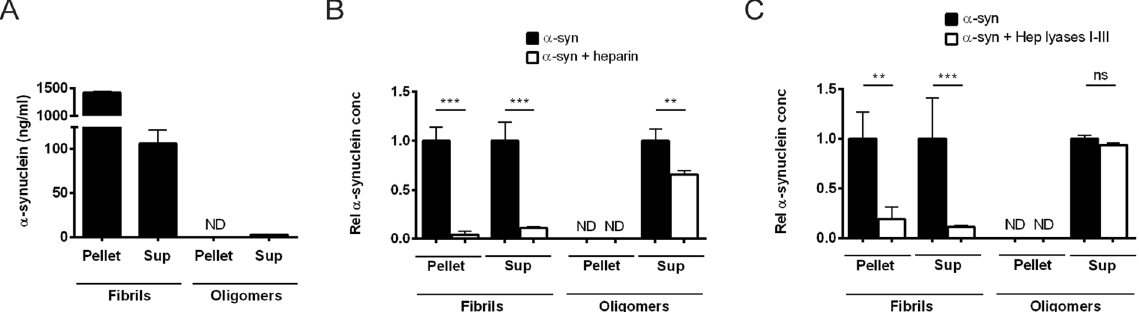
Figure 2. Cellular binding/uptake of α -synuclein amyloid fibrils, but not soluble non-amyloid oligomers, depends on heparan sulfate in B103 cells. B103 neuroblastoma cells were harvested 4 hr after addition of α -synuclein to the cell media, and cell lysates were centrifuged and separated into pellet and supernatant fractions. Each fraction was analyzed for α -synuclein content by a sandwich ELISA. The vast majority of fibrillar α -synuclein was, as expected, found in the cell lysate pellet while the non-amyloid oligomeric α -synuclein was only found in the cell lysate supernatant. ( A ) Cell binding/uptake of α -synuclein amyloid fibrils and soluble non-amyloid oligomers. ( B ) Binding/uptake of α -synuclein of cells treated with heparin (20 µ g/ml) prior to addition of α -synuclein. ( C ) Binding/uptake of α -synuclein of cells pre-treated with heparin lyases (mixture of I, II and III, 5 mU/ml) prior to addition of α -synuclein. ND = not detected. Statistical significance was analyzed by one-way ANOVA with Sidak’s multiple comparisons